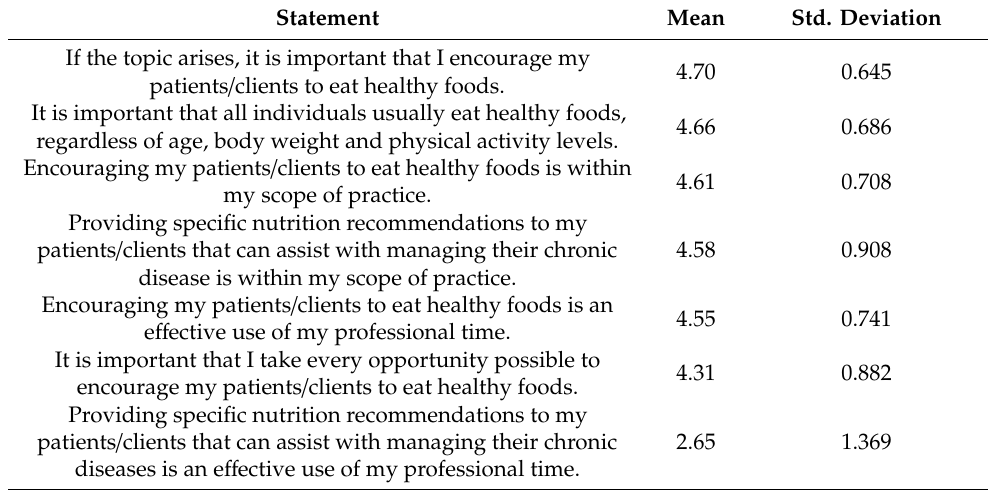
Table 2. Attitudes towards nutrition care, measured on a 1–5 Likert scale (1—absolutely not agree and 5— totally agree) in descending ordering, according to mean value.